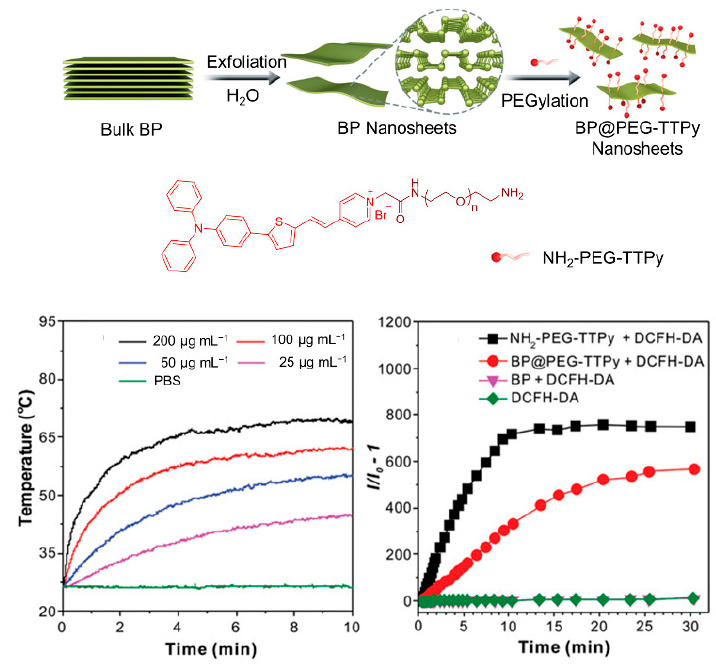
Figure 17. Synergistic therapy combining PDT. Schematic illustration of the preparation processes of BP@PEG-TTPy nanosheets and PDT/PTT effects of nanosheets. Reprinted with the permission of authors of [88]. Copyright 2020, Wiley-VCH GmbH.